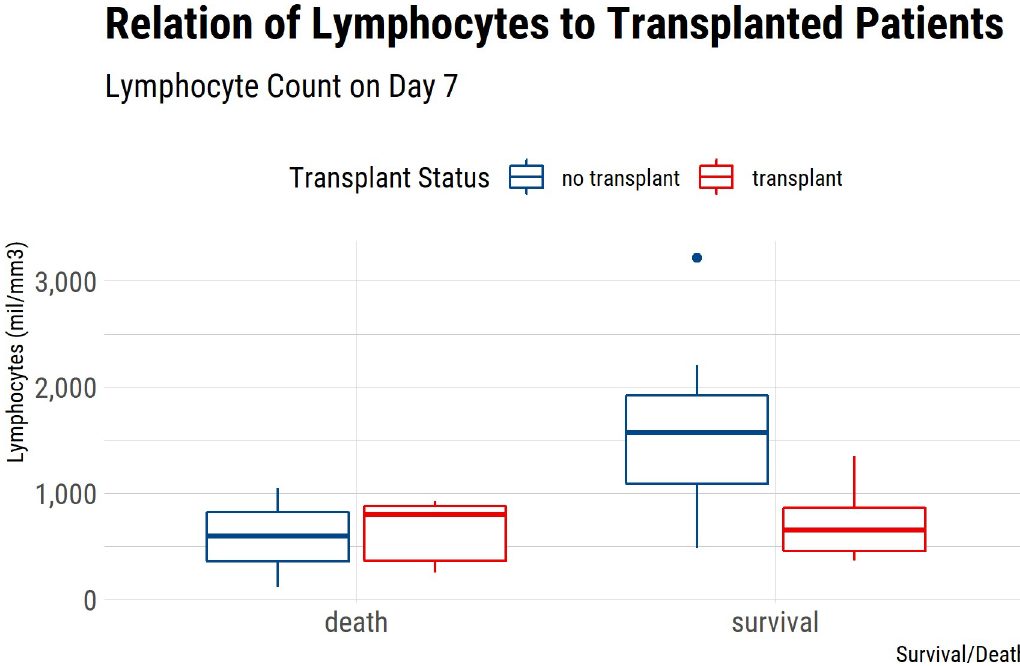
Fig 2. Lymphocyte’s cell counts at day 7 in KTR and non-KTR COVID-19 patients according to disease